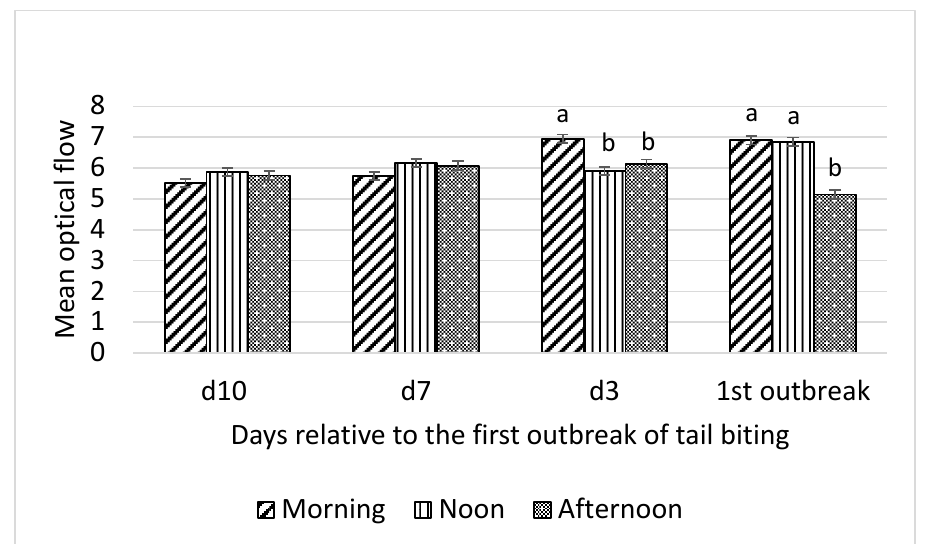
Figure 1. Interaction between day (10 d, 7 d, and 3 d before and during) relative to the first outbreak of tail biting and time of day (morning, noon, and afternoon) for mean optical flow; ab —within days means without a common superscript differ ( p < 0.01).